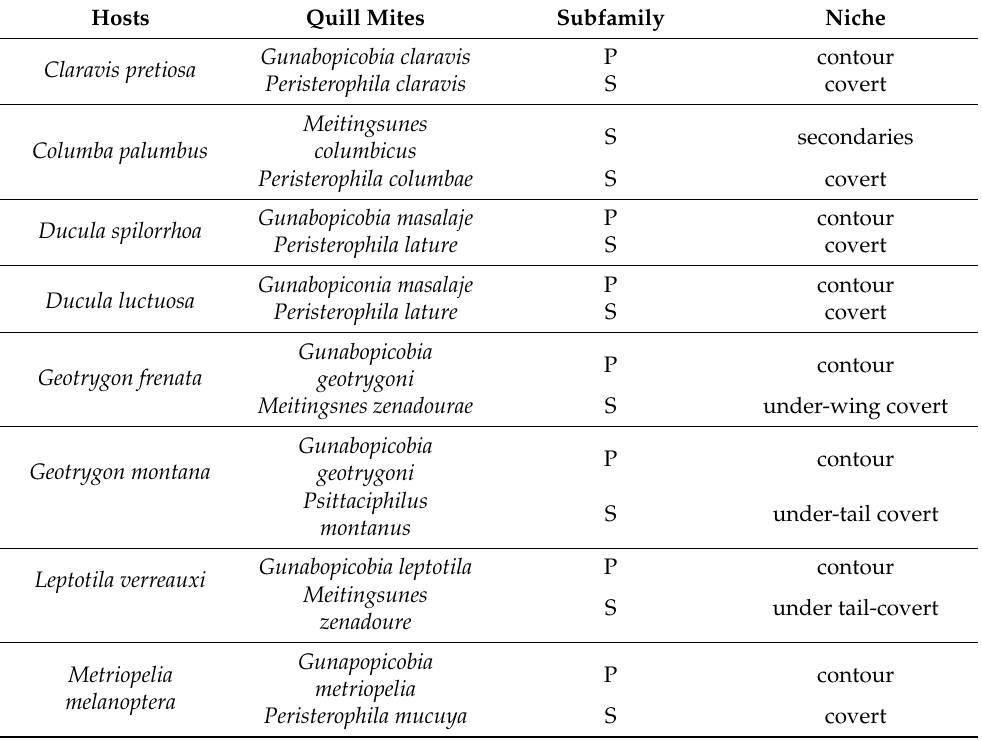
Table 5. Host species infested by two or more syringophilid species with notation of the habitat preference; P—Picobiinae;